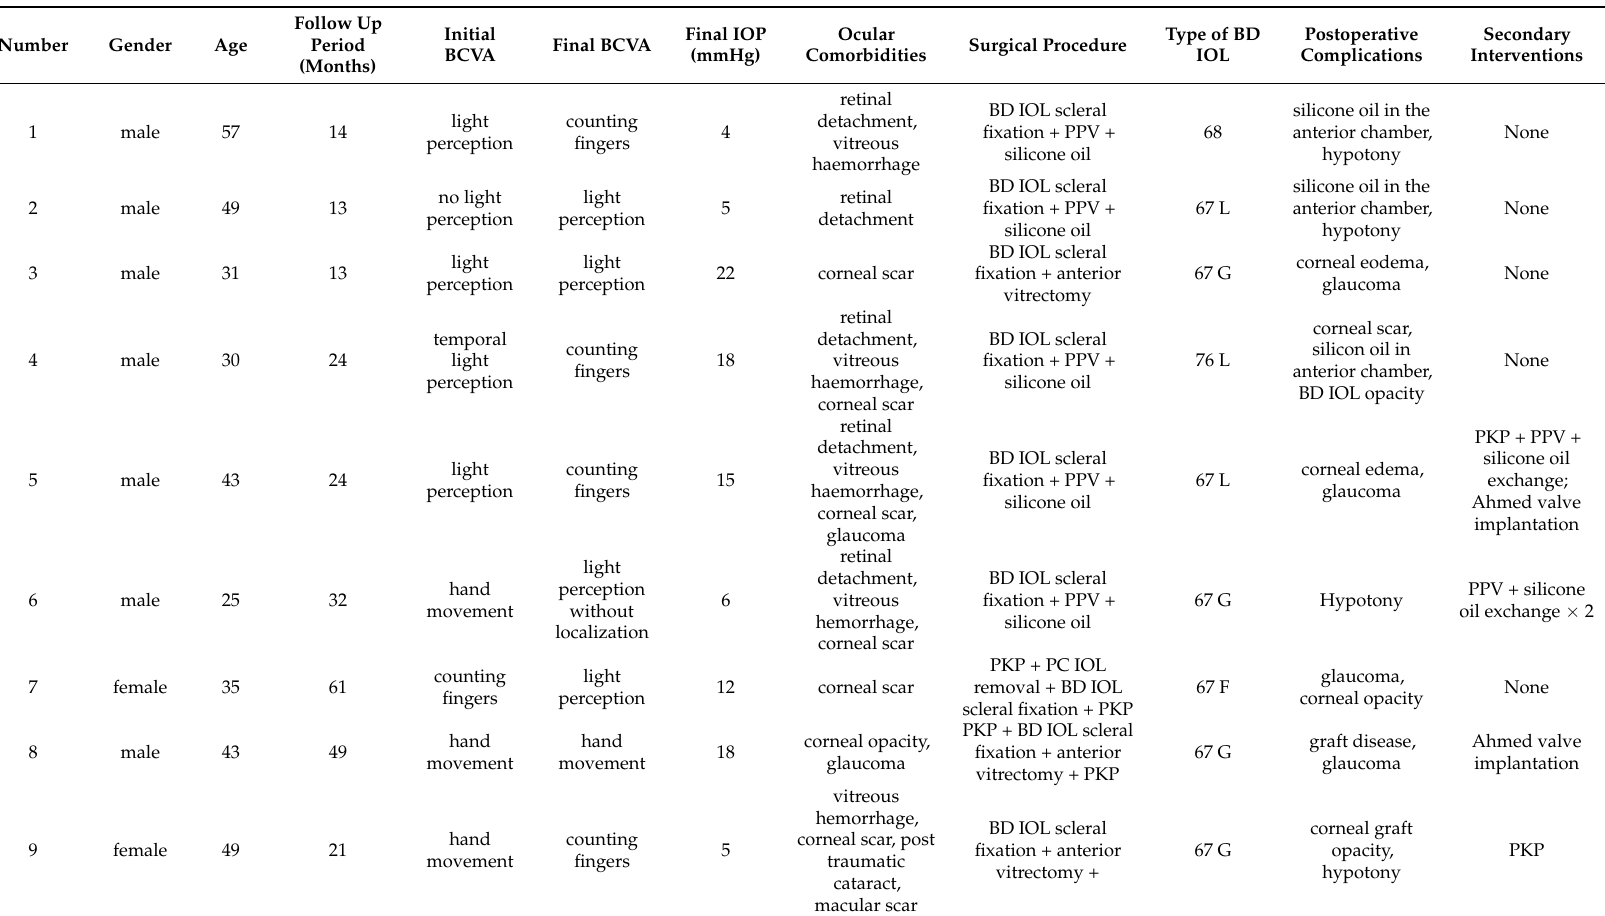
Table 1. Status of 14 patients monitored after black-diaphragm intraocular lens (BD IOL) implantation: gender, age, initial and final best-corrected visual acuity (BCVA), postoperative intraocular pressure, ocular comorbidities, surgical procedure, type of BD IOL, postoperative complications and secondary